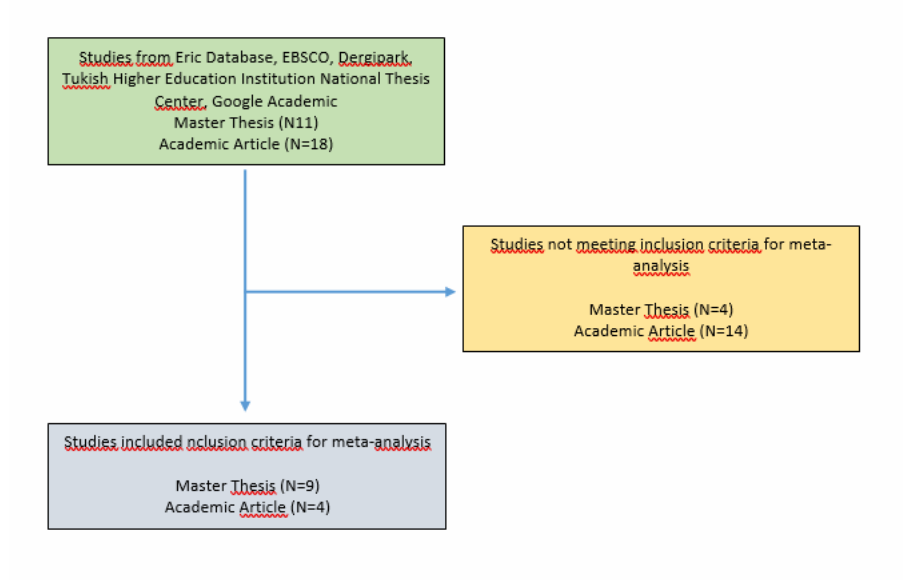
Figure 1. Studies regarding criteria for inclusion in the